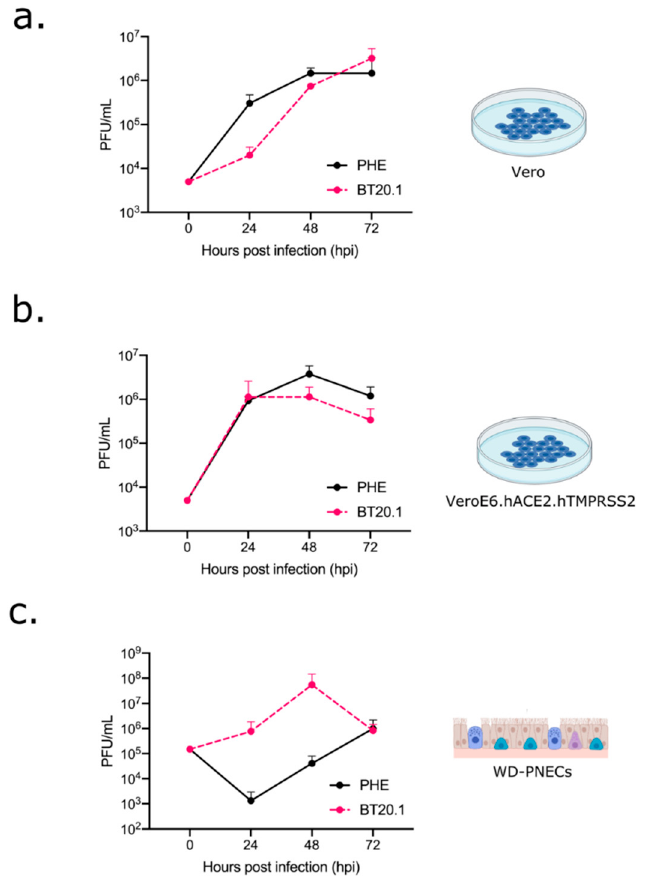
Figure 4. Comparison of PHE P4 (Vero) and BT20.1 P4 (Vero) growth on different cell substrates. Multicycle growth curves (MOI 0.01 for Vero or 0.1 for WD-PNECs) for PHE P4 (VeroE6) and BT20.1 P4 (Vero) on Vero ( a ), VeroE6 cells expressing human ACE2 and human TMPRSS2 ( b ) and adult WD-PNECs from 3 donors ( c ). Titres for Vero-derived cells are shown as means +/ − SEM for tripli- cate wells and are representative of two independent experiments. Titres for WD-PNECs are shown as means +/ − SEM for single wells from 3 donors. Data using BT20.1 are presented here as averages from 3 donors but have also been incorporated into a sister paper using separated, individual donor data [24]. Figures were generated with the aid of BioRender